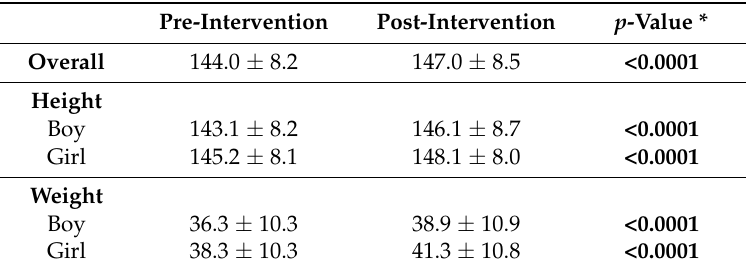
Table A1. Anthropometric measures of ORANGE study participants pre- and post-intervention, overall and by gender ( n =